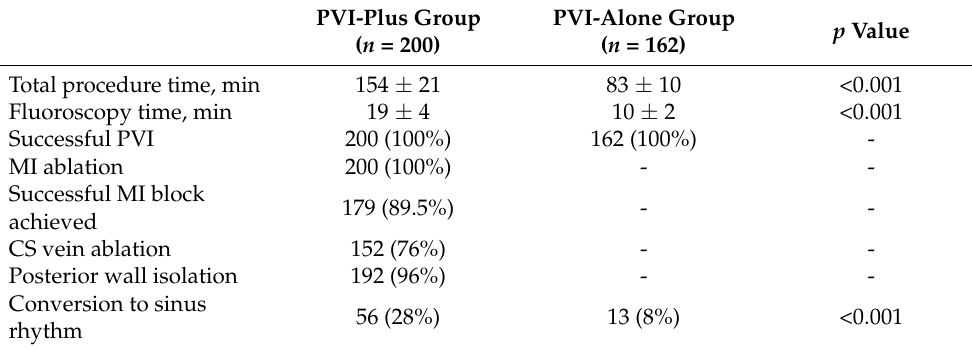
Table 2. Procedural